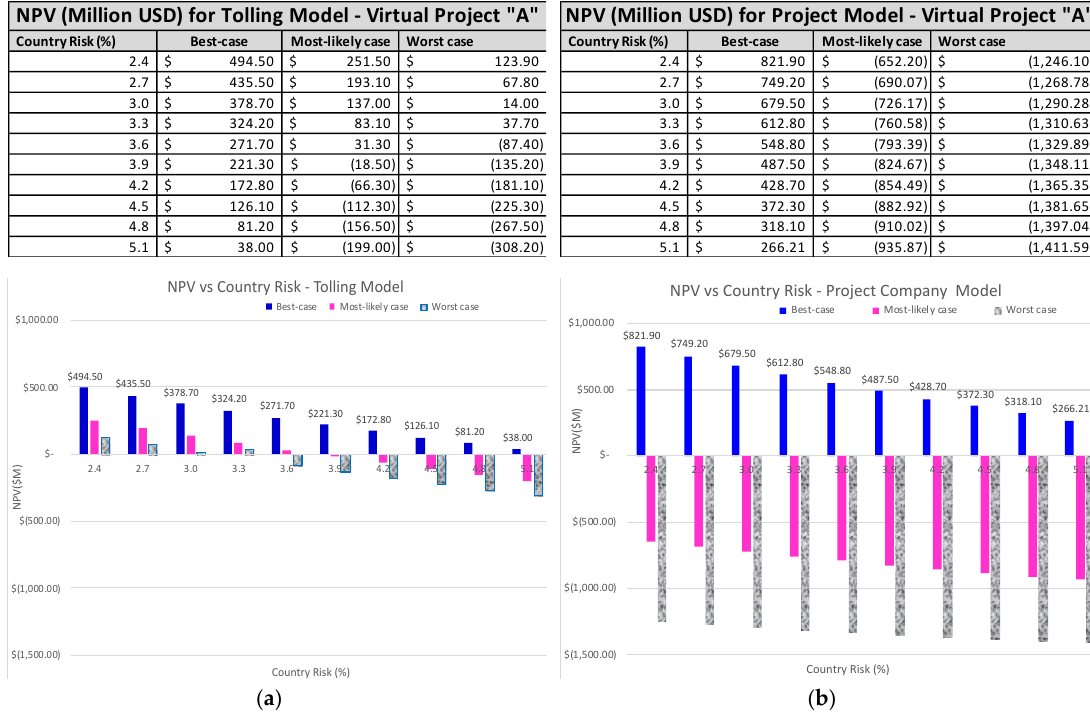
Figure 6. NPV sensitivity: ( a ) tolling model; and ( b ) project company model.